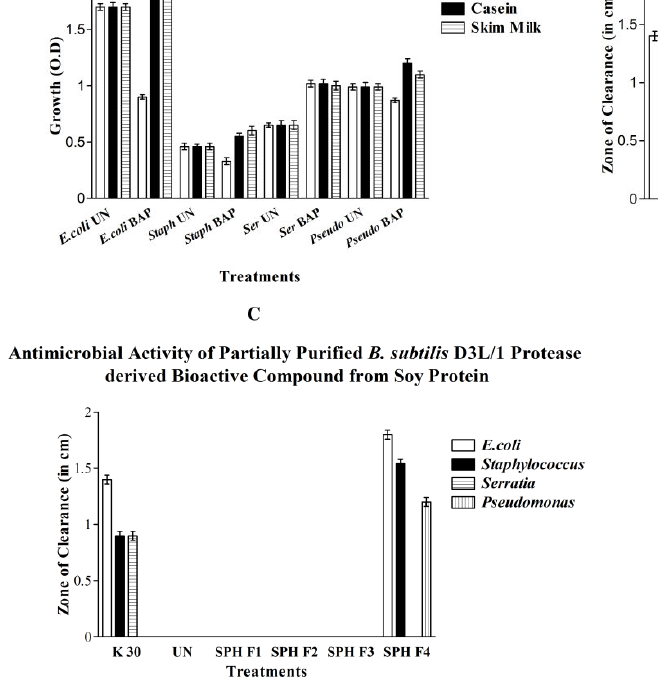
Figure 8. Determination of antimicrobial activity of bioactive peptides using Bacillus subtilis D3L/1 protease as hydrolyzing enzyme. ( A ) Enzyme hydrolysis effect on different substrates to check suppression of bacterial growth in order to confirm bioactive peptide formation. Bar represents bacterial growth; ( B ) determination of zone of clearance in soy protein-derived hydrolyzed bioactive compound samples of different time point to check antimicrobial efficiency. Bar represents the zone of clearance (in cm); K30: kanamycin antibiotic disc (30 µ g/disc); UN: untreated; BAP: bioactive peptide.( C ) Antimicrobial activity of partially purified bioactive sample to determine the possible size of the active compound through ultrafiltration. Bar represents the zone of clearance (in cm) and Fraction 1–4 (SPH-F1-SPH-F4) had the size approximately >30 KDa, 10–30 KDa, 3–10 KDa,